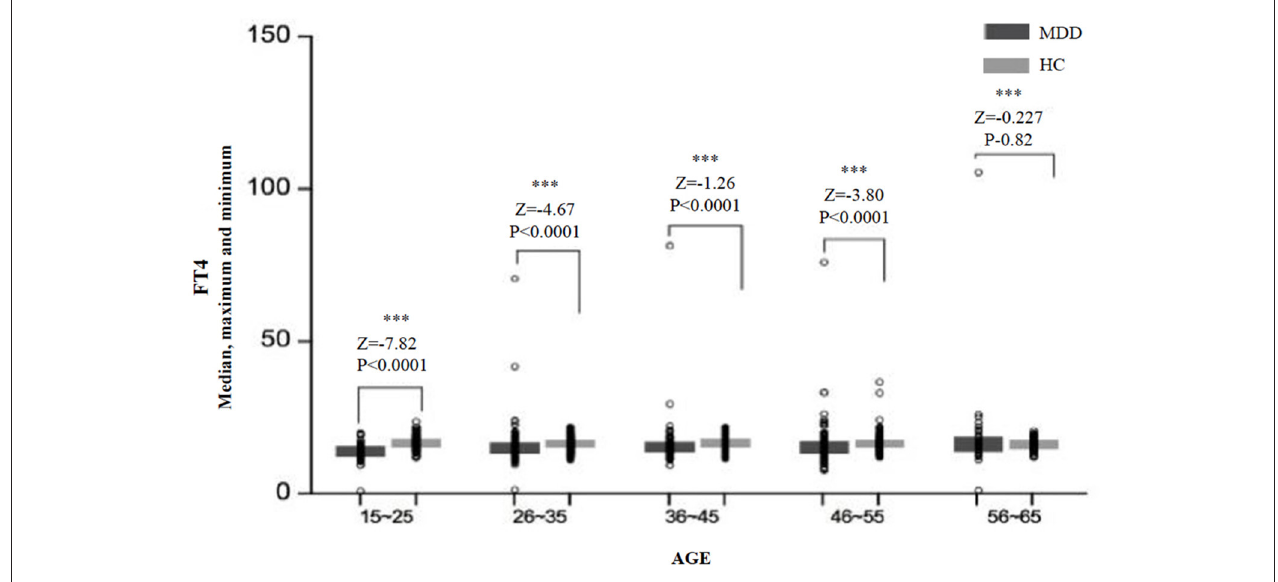
FIGURE 3 | The median, maximum, and minimum values of the FT4 level ( pmol/L ) at different ages in the MDD and HC groups. *** <